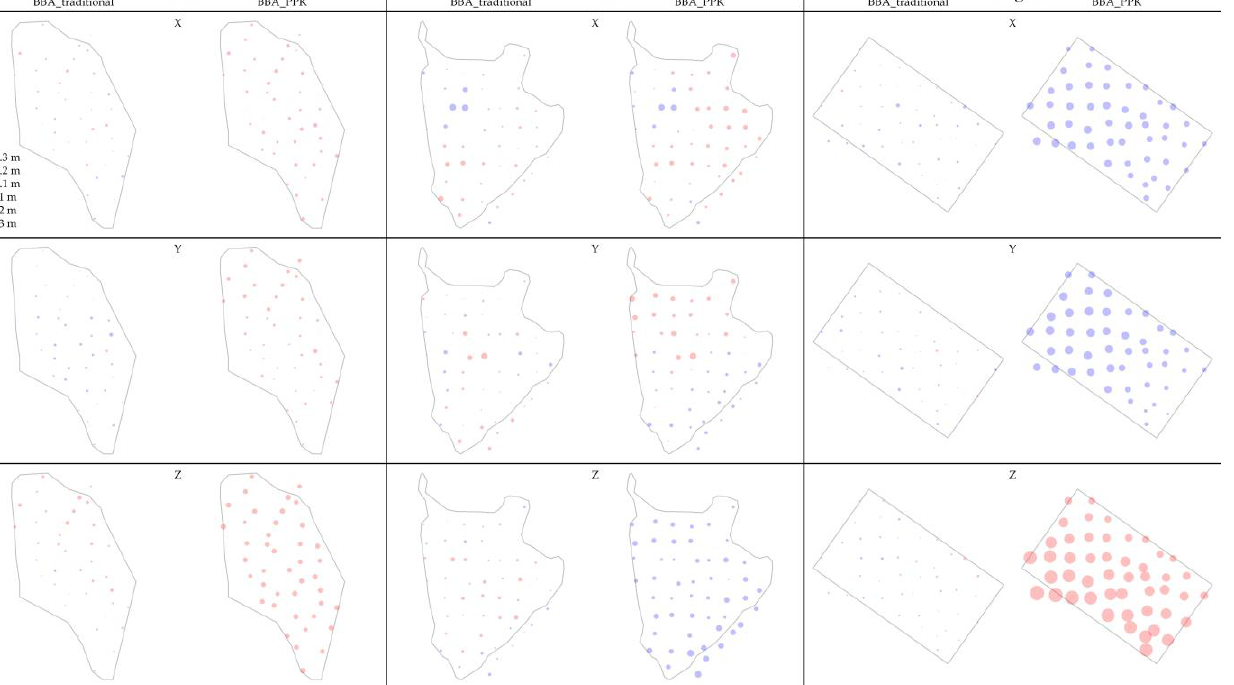
Figure 9. Spatial distribution of the differences in X, Y and Z coordinates, calculated for accuracy assessment of BBA produced by the BBA_traditional and the BBA_PPK method.